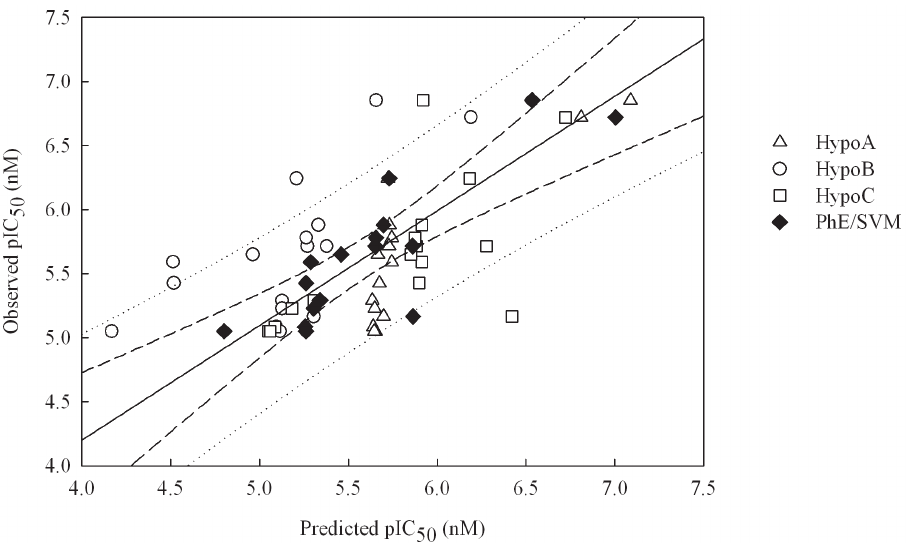
Figure 7. Observed vs . predicted pIC 50 values in the outlier set. Observed pIC 50 vs . the pIC 50 predicted by Hypo A, Hypo B, Hypo C, and PhE/ SVM for those molecules in the outlier set. The solid line, dashed lines, and dotted lines correspond to the PhE/SVM regression of the data, 95% confidence interval for the PhE/SVM regression, and 95% confidence interval for the prediction, respectively.